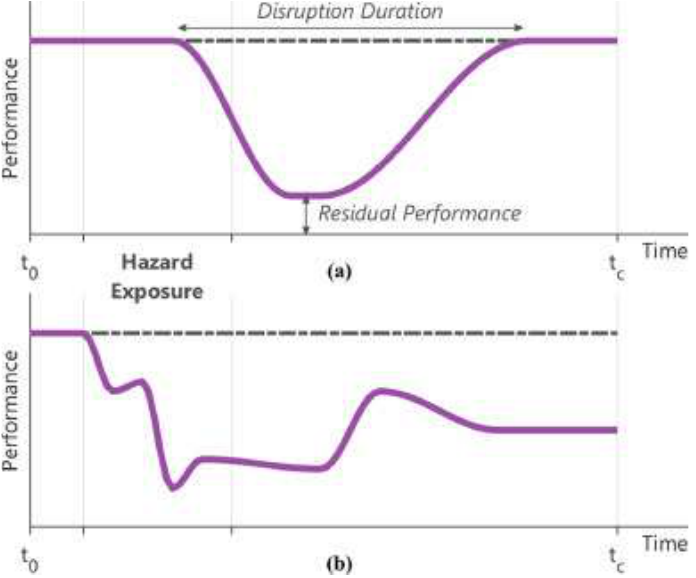
Figure 1. ( a ) Typical resilience representation with two possible summary metrics; ( b ) resilience representation curve showing non-idealized system behavior. Source: [39].